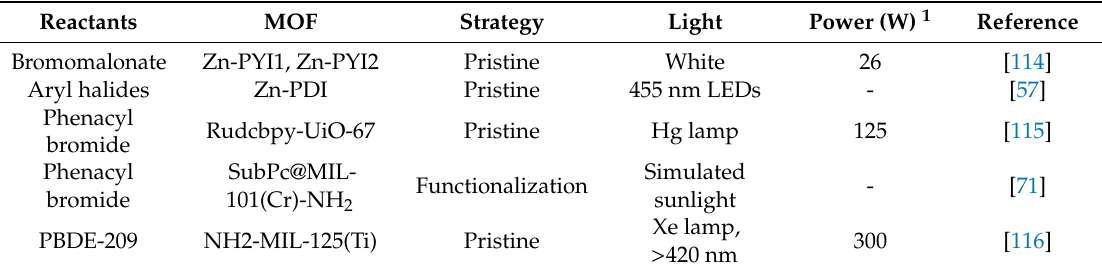
Table 14. Photocatalytic dehalogenation reactions mediated by MOFs.